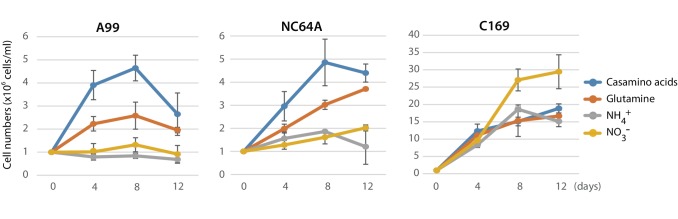
Growth of green algae in presence of various nitrogen sources.The growth rate of Chlorella A99 (A99), Chlorella variabilis NC64A (NC64A) and Coccomyxa subellipsoidea C-169 (C169) by in vitro culture was assessed for different nitrogen sources with casamino acids (blue), glutamine (orange), ammonium (gray) and nitrate (yellow). Mean number of algae per ml were determined at 4, 8, 12 days after inoculation with 106 cell/ml. Error bars indicate standard deviation.